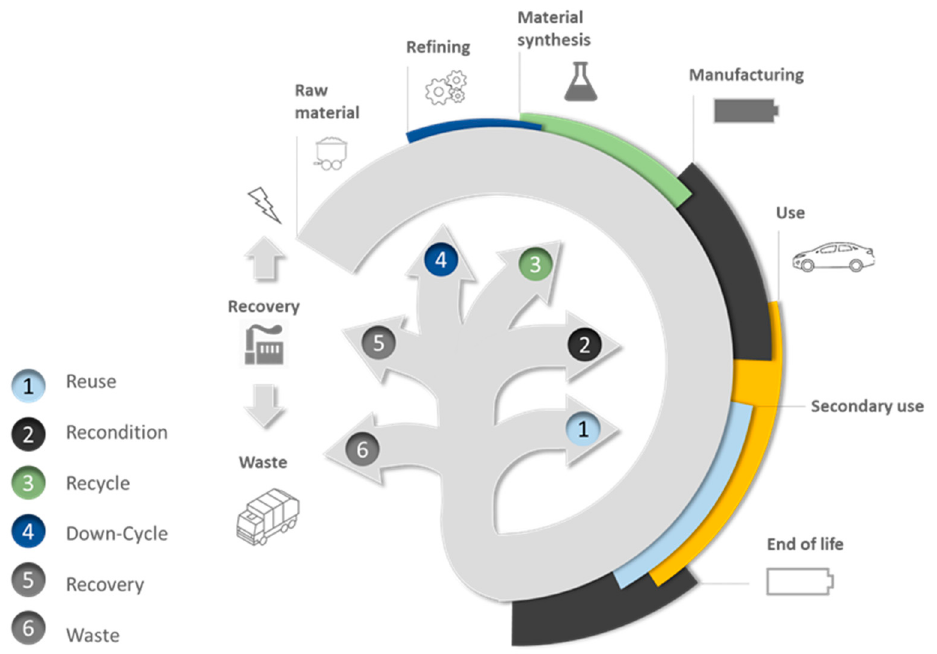
Figure 5. Cyclic flow chart of manufacturing, usage, and end-of-life of Li-ion batteries.